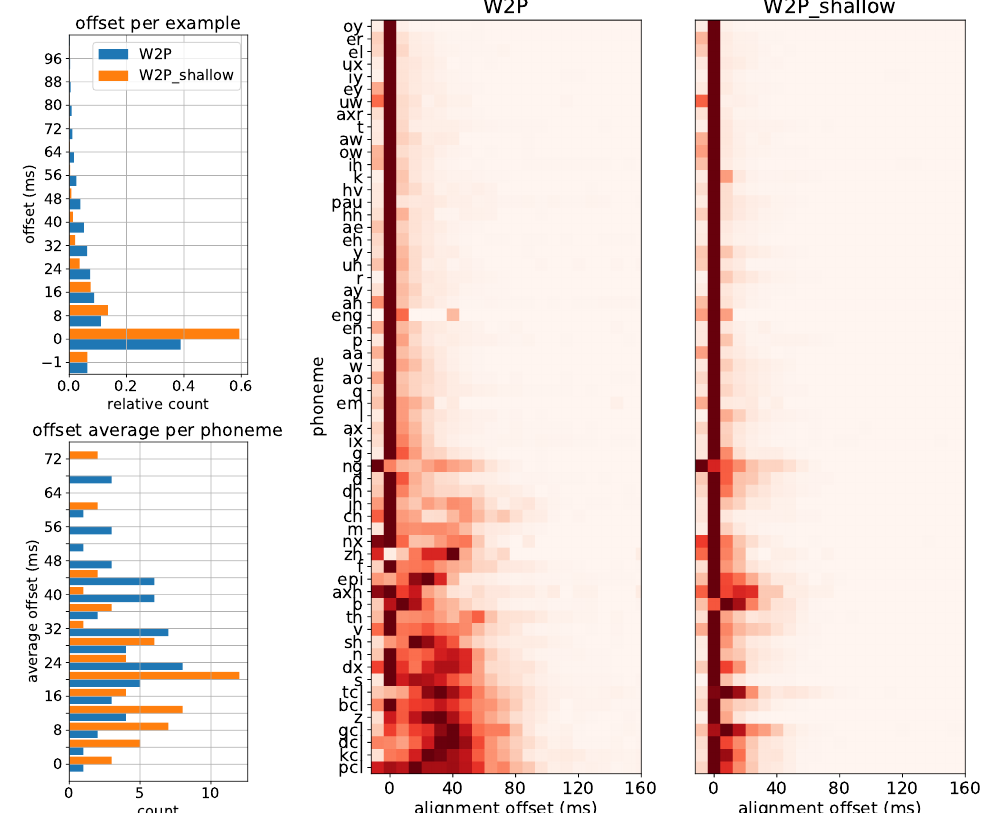
Figure 2. Alignment offset overview in phoneme prediction models. Distribution of offsets for all examples ( top left ) and of the average alignment offset per phoneme ( bottom left ). The center and right plots show offset distributions per phoneme in models W2P and W2P_shallow. Counts in the heat map plots are scaled to the range [0,1] for each phoneme, respectively. An offset value of − 1 indicates that the predicted phoneme is not in the annotation of the example. The highest 5% of the alignment offset values are excluded for plotting as their frequency was too low to be